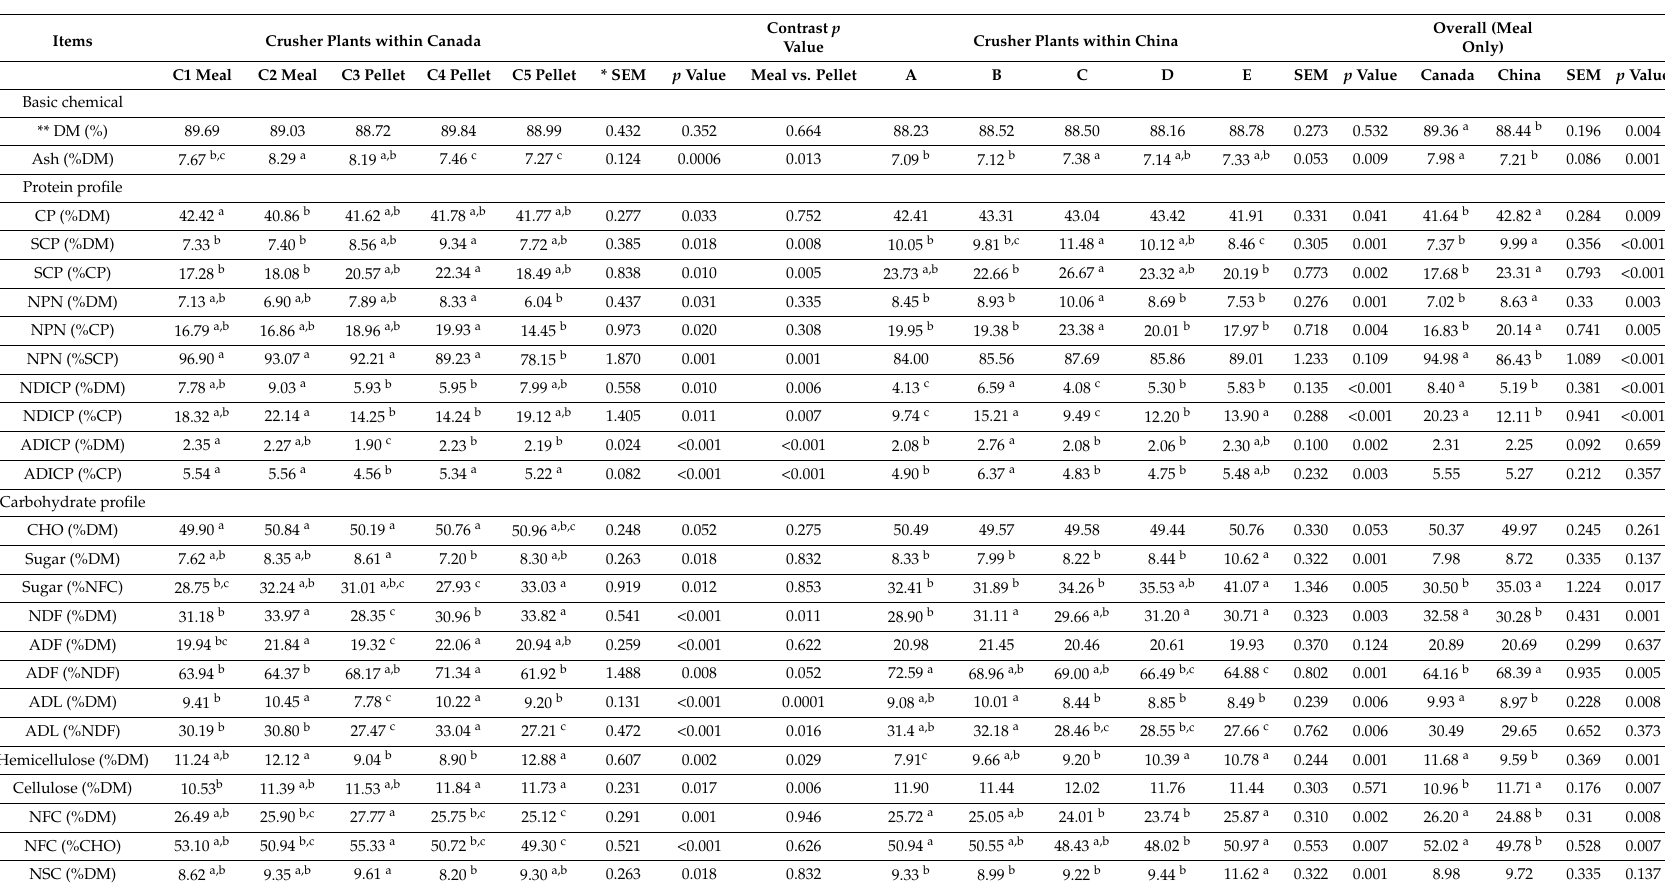
Table 2. Bioactive compounds, anti-nutritional factors and chemical composition of co-products from bio-oil processing (canola meal): Comparison of crusher plants within Canada and within China as well as between Canada and